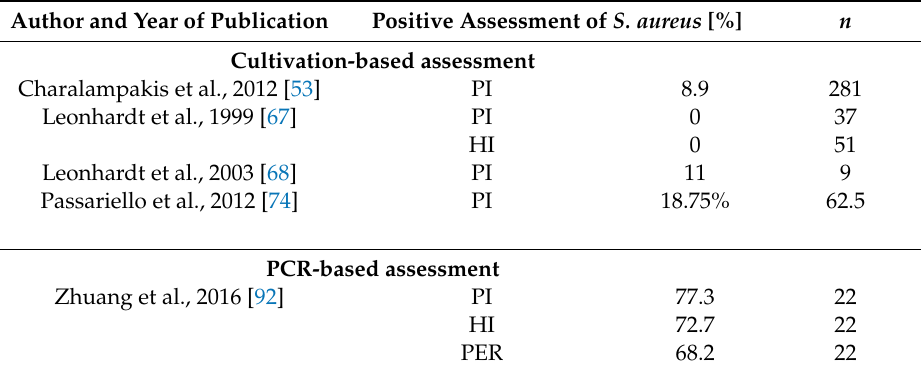
Table 7. Studies specifically assessing S. aureus.